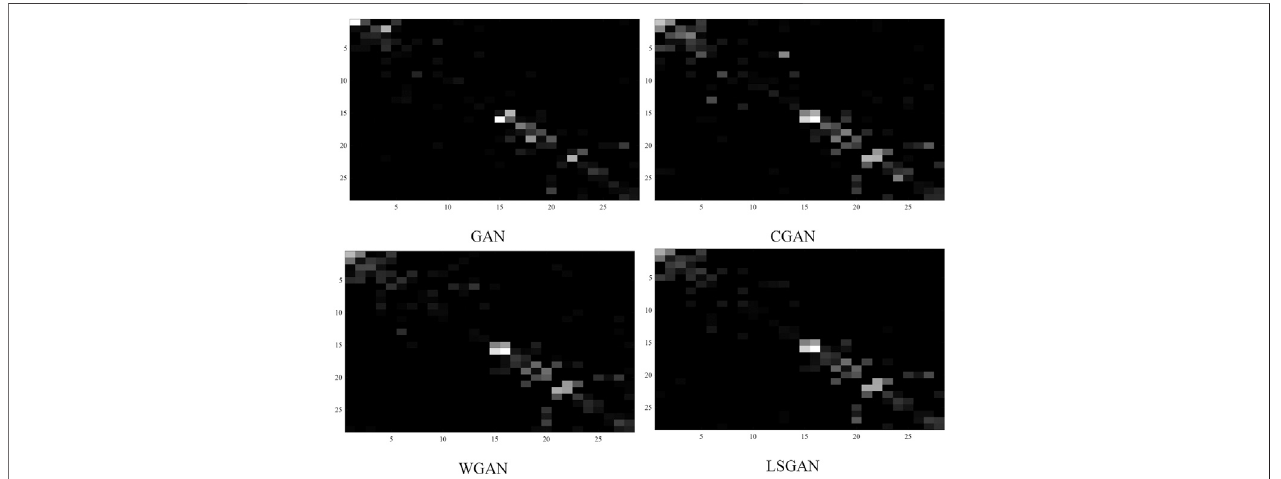
FIGURE 6 | The grayscale map is drawn from the generated data by GAN, CGAN, WGAN, LSGAN.